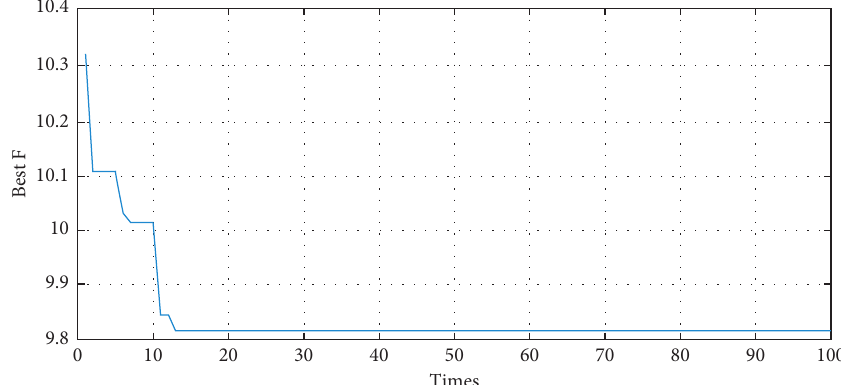
Figure 27: Results of genetic algorithm